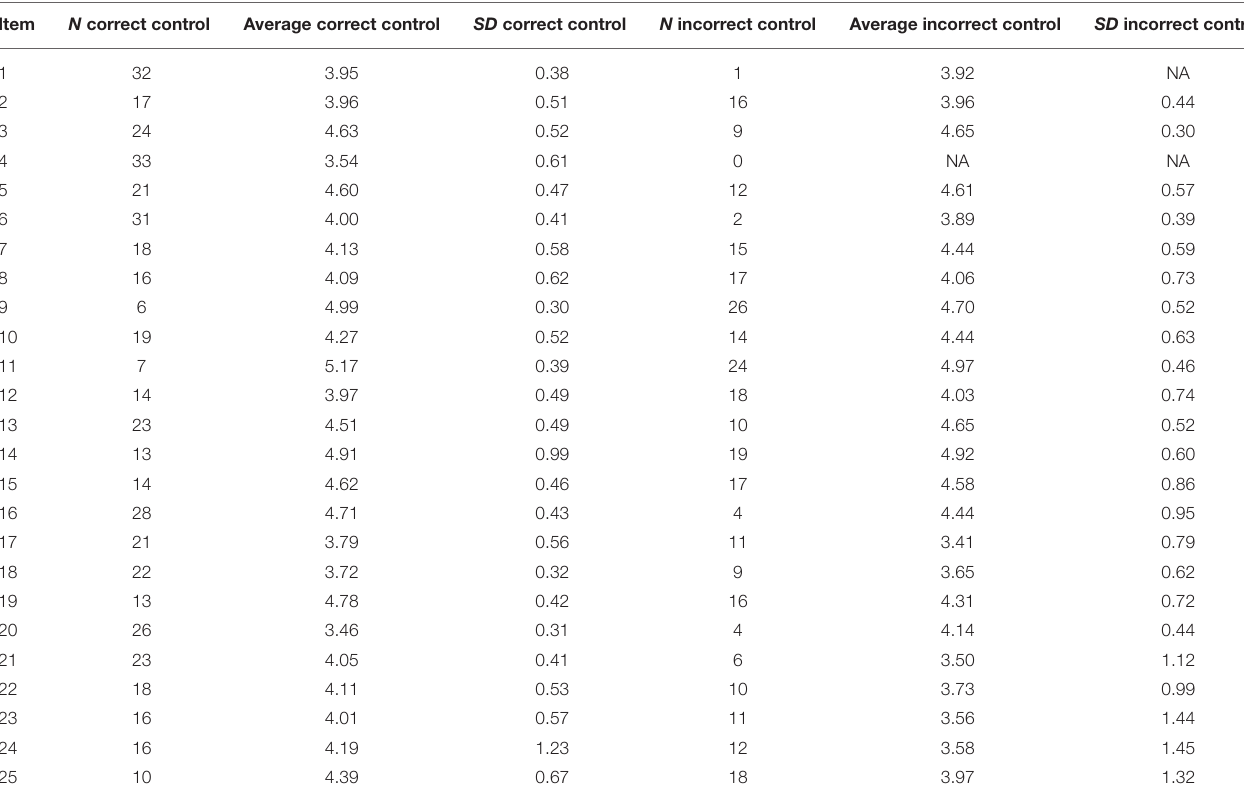
TABLE 2 | Descriptive statistics of control group for computing conditional zRTs.